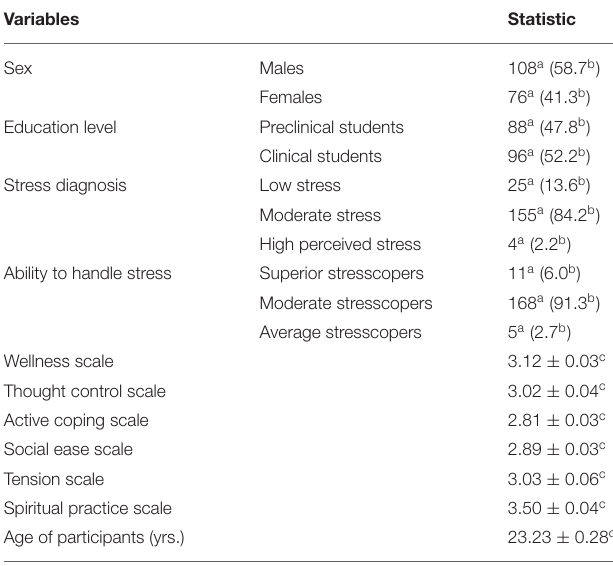
TABLE 2 | Descriptive statistics on social demographics, stress and stress copying